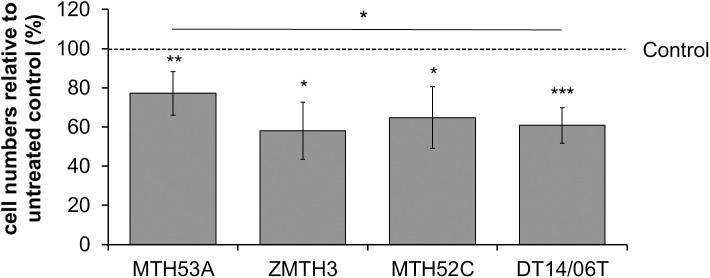
Influence of 10 mM DCA on mammary cell lines after 48 hours.Statistical significant reduction of cell number was observed in all cell lines. Significant difference in cell number between MTH53A and mammary carcinoma DT14/06T was observed. Data is shown as mean ± standard deviation (SD), n≥3 and are presented as relative cell numbers in comparison to the respective corresponding untreated control (%). Control values were set to 100%. Statistical analysis was performed with two-tailed t-test, *p<0.05, **p<0.01, ***p<0.001.